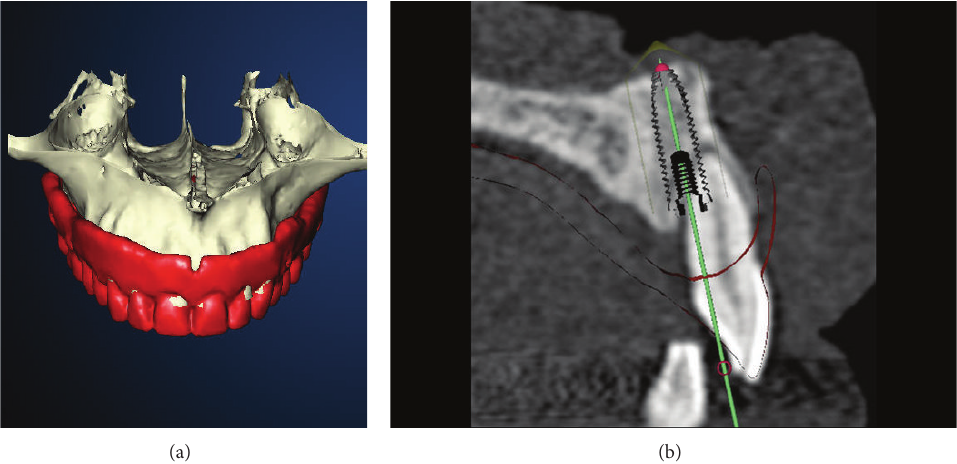
Figure 3: (a) Even if this template has never been worn by the patient, it can be merged to the patient CT data because of the radiographic markers. (b) Respect of the prosthetic project is easier with the computer-aided technology than in conventional hands-free procedure for immediate implants.